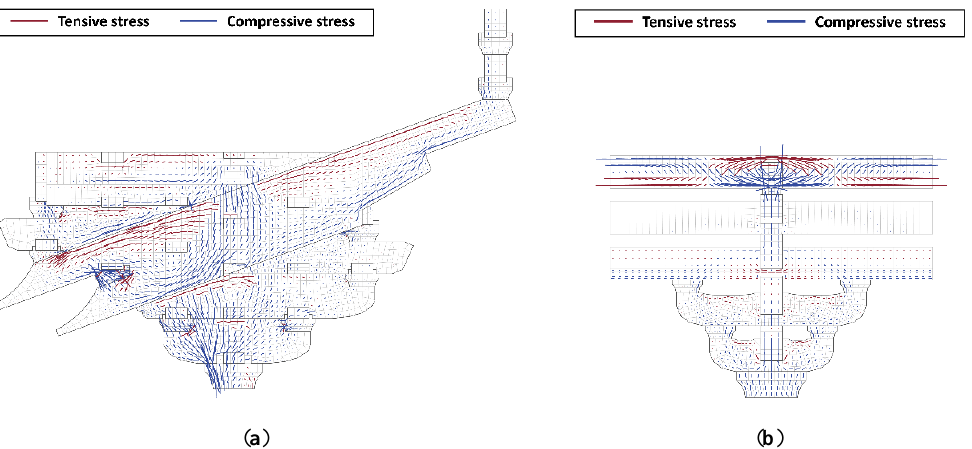
Figure 8. Stress vector diagram of the Ji-xin-zao Dou-gong in the roof load case: ( a ) longitudinal section; ( b ) transverse section.